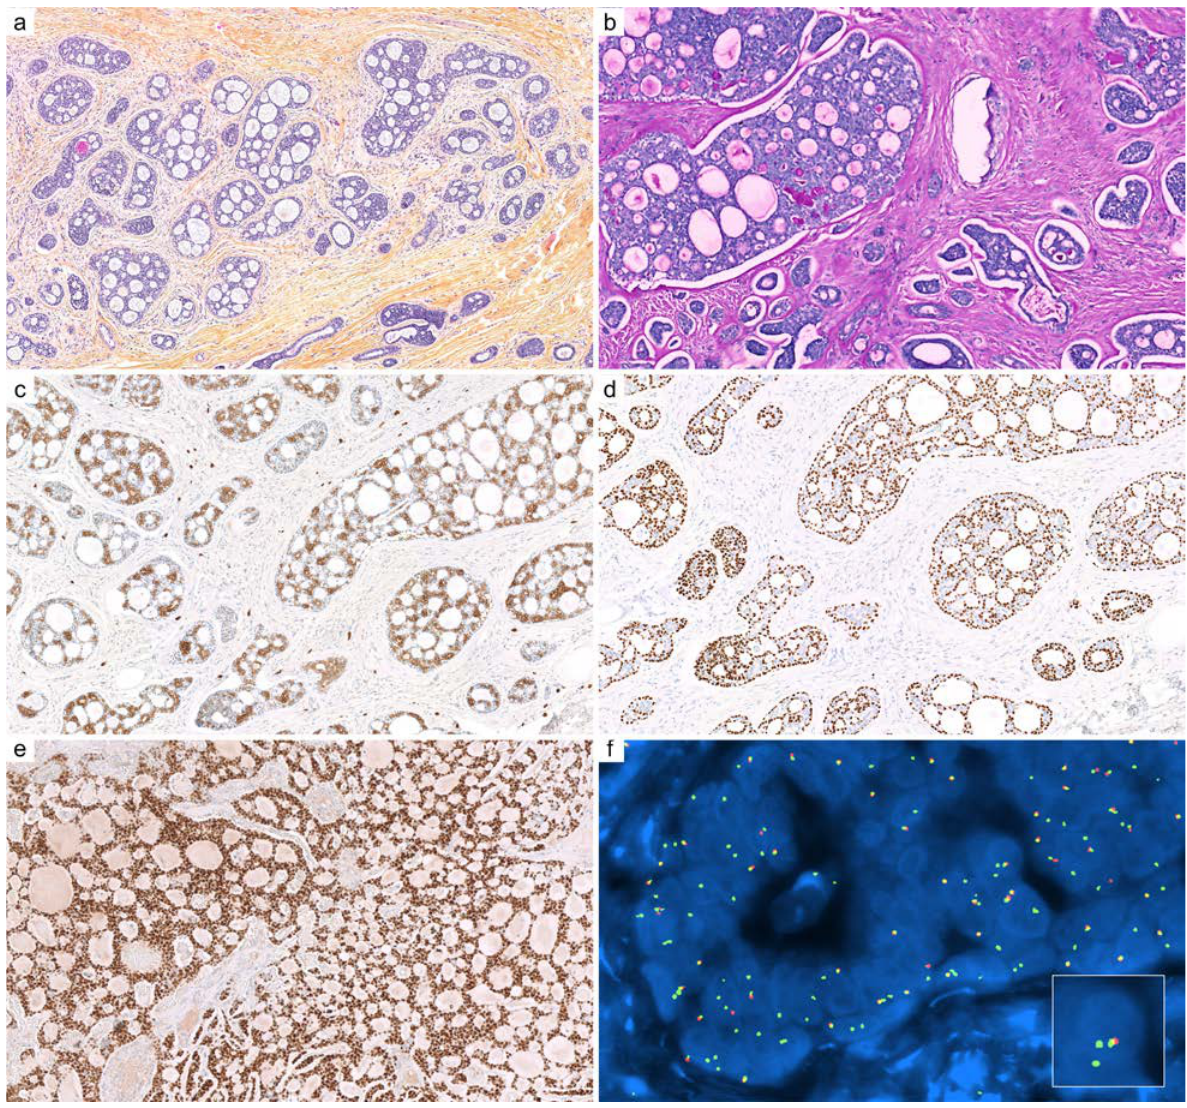
Figure 1. Cutaneous adenoid cystic carcinoma (ACC): ( a ) ACC is arranged in various cribriform aggregates and ductal structures (HPS, × 100); ( b ) periodic acid-Schiff (PAS) reaction highlights entrapped basement membrane material within aggregates (HPS, × 200); ( c ) c-KIT (CD117, × 200) im- munohistochemistry stains luminal cells; ( d ) immunostaining for p63 highlights outer myoepithelial cells with a discontinuous pattern (×200); ( e ) SOX10 immunohistochemistry is intensely and dif- fusely positive in the nuclei of ACC (×200); ( f ) fluorescence in situ hybridization (FISH, break-apart probe) demonstrates a clonal rearrangement of MYB in neoplastic cells (×1000).